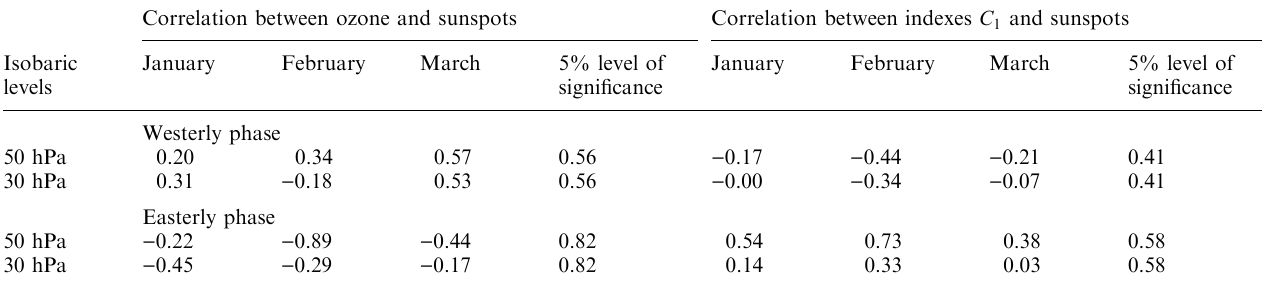
Table 3. Coe(cid:129)cients of linear correlation between the monthly means of total ozone over Northeastern Europe and the sunspot numbers, as well as between the monthly mean indexes C 1 and the sunspot numbers, during the di(cid:128)erent QBO phases defined separately at 50 and 30 hPa. For the analyses the monthly ozone means for 1973–1995 with subtracted linear trend for this period and monthly means of index C 1 for 1958–1996 were used. In the first case, total ozone data used for the correlation analysis, were 15 for westerly and 8 for easterly phases of QBO. In the second case, the used data for C 1 , were 25 for westerly and 14 for easterly phases of QBO Correlation between ozone and sunspots Correlation between indexes C 1 and